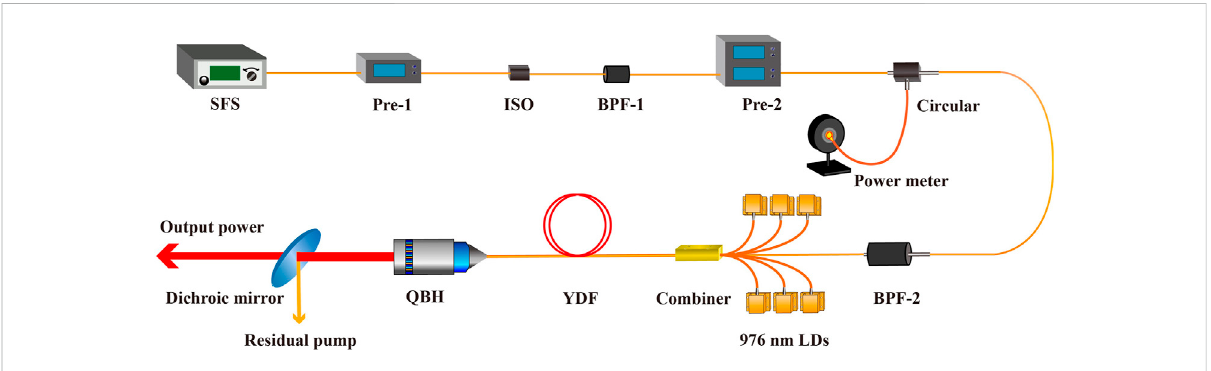
FIGURE 1 Schematic of the experimental setup.